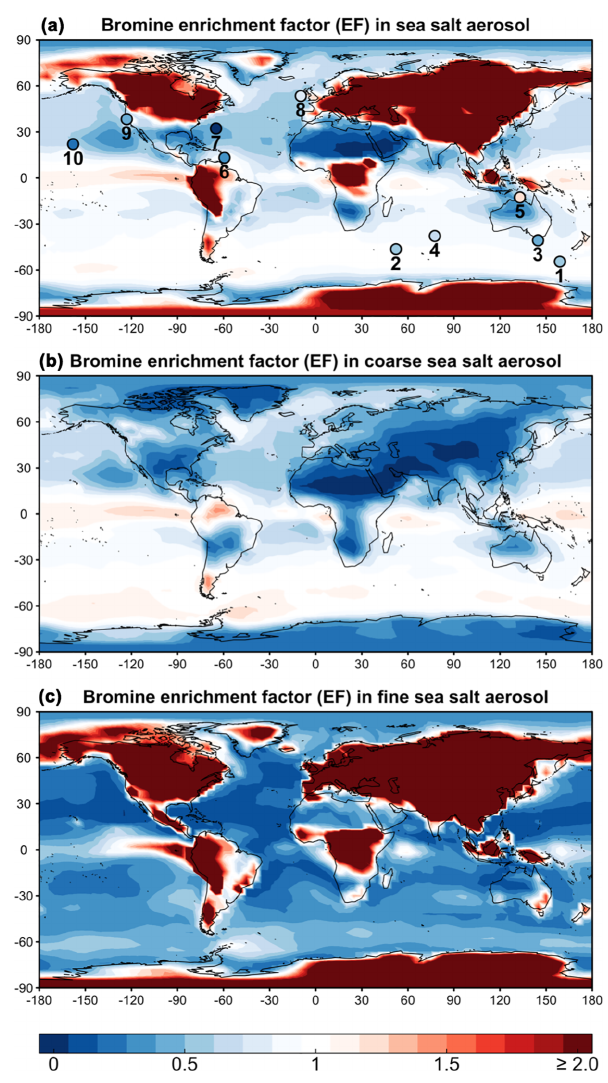
Figure 1. Annual mean bromine enrichment factor (EF) of sea salt aerosol (SSA) in surface air. GEOS-Chem model results (contours) are compared to observations (circles in a ). (a) shows results for to- tal SSA (fine + coarse), (b) is for coarse SSA ( > 0 . 5µm radius), and (c) is for fine SSA ( ≤ 0 . 5µm radius). Observations at 10 sites com- piled by Sander et al. (2003) and from Newberg et al. (2005) are su- perimposed as circles and labeled in order 1–10: Macquarie Island, Crozet Islands, Cape Grim, Amsterdam Island, Jabiru, Barbados, Bermuda, Mace Head, Bodega Bay, and Hawaii, respectively. The simulation is for 2012 and the observations are for different years. Color bar saturates at 2.0. Maximum modeled EF is 75.0.